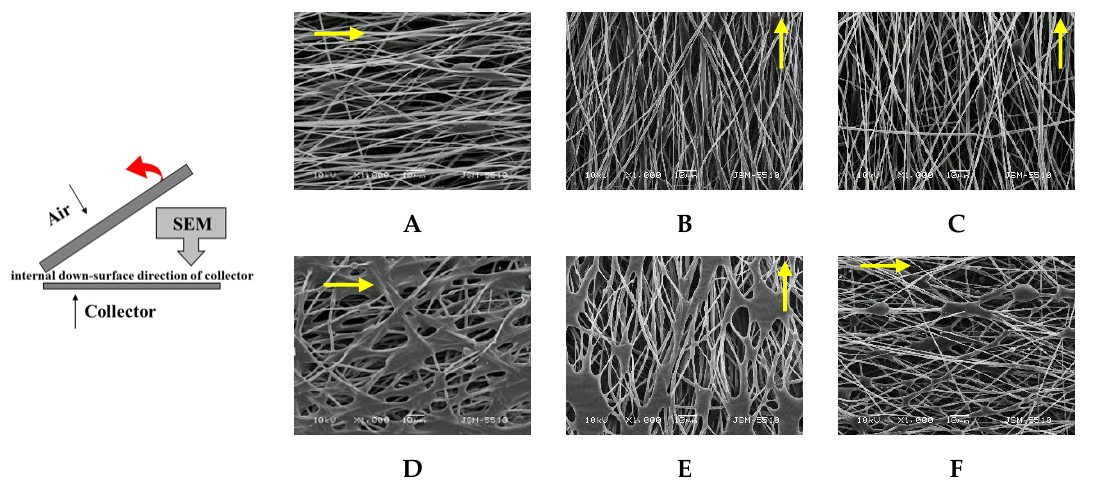
6 of 11 Figure 4. SEM micrographs of the PHB/PCL mats before ( A – C ) and after ( D – F ) thermal treatment onto rotating drum ( A, D ), blade ( B, E ) and grid ( C, F ) collectors. The direction of the collector rotation is indicated by arrows. It is noteworthy that, depending on the concentration of the spinning solutions, which were subjected to dual-jet electrospinning, the morphology of the fibers was different. From the presented SEM micrographs, it can be seen that before thermal treatment (Figure 4A – C), the dual-jet electrospinning of PHB and PCL under the selected conditions and concentrations resulted in the formation of two types of fibers — defect-free cylindrical ones and fibers with spindle-like defects along their length. The average fiber diameters of the defect-free fibers before thermal treatment were 907 ± 94 nm for PHB/PCL (drum), 1072 ± 103 nm for PHB/PCL (blade) and 1084 ± 98 nm for PHB/PCL (grid), whereas those of the fibers with spindle-like defects were 586 ± 86 nm, 794 ± 77 nm and 776 ± 81 nm, respectively. The defects have the following mean length and mean width of the “spindles” (L/W): 20 ± 6,1 µm/6,3 ± 0,8 µm for PHB/PCL (drum), 15 ± 2 µm/5,9 ± 0,2 µm for PHB/PCL (blade) and 16,7 ± 2,3 µm/4,0 ± 0,7 µm for PHB/PCL (grid). As seen from SEM micrographs (Figure 4D – F), in general, the fibrous structure of the PHB/PCL mats was preserved after thermal treatment above the T m of PCL. However, “segment” sealing of the fibers in the molten sites along their length was achieved. Probably because of the heat treatment above the T m , the formation of “segment” sealing was observed only in the molten PCL defect sites. Therefore, it is evident that the defect-free fibers were of PHB, while those with spindle-like defects were of PCL. After thermal treatment, the mean fiber diameters were 1031 ± 135 nm for PHB/PCL (drum), 1341 ± 404 nm for PHB/PCL (blade) and 1120 ± 268 nm for PHB/PCL (grid). This slight increase in the mean diameters was probably due to the covering of the PHB fibers by the molten PCL. To prove that the morphology of the PHB/PCL mats and their fiber alignment were preserved in the bulk of the mats, their internal structure was also observed by SEM (Figure 5). For this purpose, the PHB/PCL mats were longitudinally cleaved — as shown in the scheme in Figure 5 — and the inner